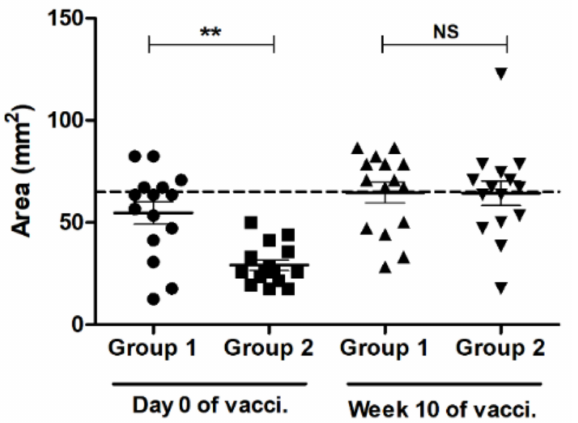
Figure 2. Mean EIV-specific antibody relative concentration determined by single radial hemolysis (SRH) assay. Serum samples were collected from groups 1 (G1) and 2 (G2) after six months of immunization (V1—day 0) with either Calvenza-03 EIV/EHV ® (Group 1; G1: black circles) or Fluvac Innovator ® (Group 2; G2: black squares) and after 10 weeks (V2—10 weeks) of booster immunization with Calvenza-03 EIV/EHV ® for horses of both groups (G1: upright black triangles; G2: downright black triangles). SRH assay was performed as described in the materials and methods. Total area of hemolysis was measured in mm 2 . The central line in the scattered dot plot indicates the mean of the data with standard error of mean (error bars). ** A significant increase (2-way repeated measures ANOVA with Tukey’s multiple comparisons post-test; p < 0.01) of hemolysis area for group 1 was seen when compared to group 2. NS—not significant;